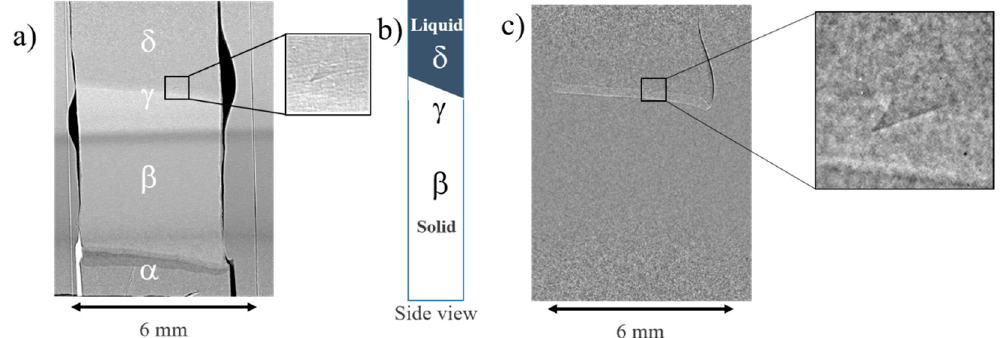
Figure 1. X-ray radiography image recorded during solidification (applied temperature gradient: 30 K / cm and cooling rate of − 1 K / min applied on both heaters) from a FZ-Si seed. ( a ) Image resulting from the pixel by pixel division of the current image by the first image after starting the cooling down ( α : seed–regrown interface, β : fully solid region, γ : solid–liquid interface region, δ : fully liquid region). ( b ) Sketch of the side view. ( c ) Image resulting from the pixel by pixel division of two successive raw images with a time interval of 3 s and close-up at the level of the interface at the same instant and position as in ( a ).